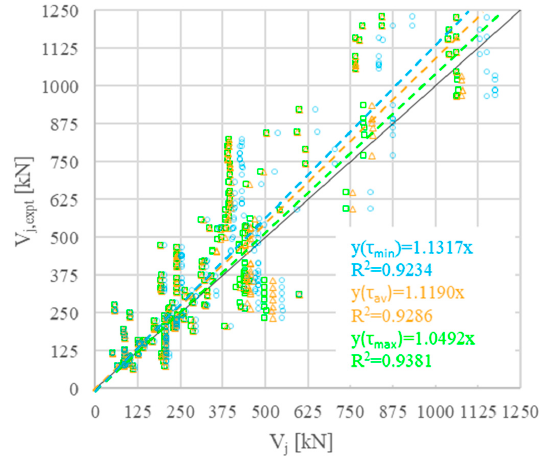
Figure 7. Experimental and numerical comparison for T-shaped RC joints under positive column shear: minimum bond stress (blue), average bond stress (orange), and maximum bond stress (green).